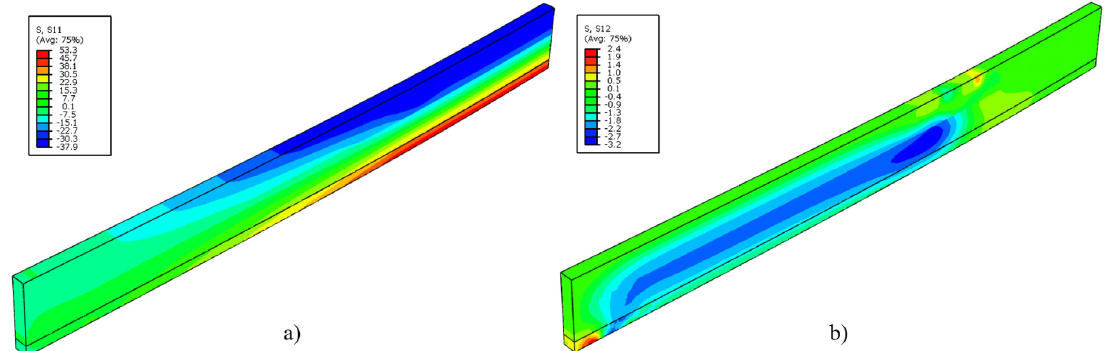
Fig. 10 . Stress (MPa) distributions in glulam at ultimate load for Series B beams: a) normal σ 11 stress and b) shear σ 12 stress